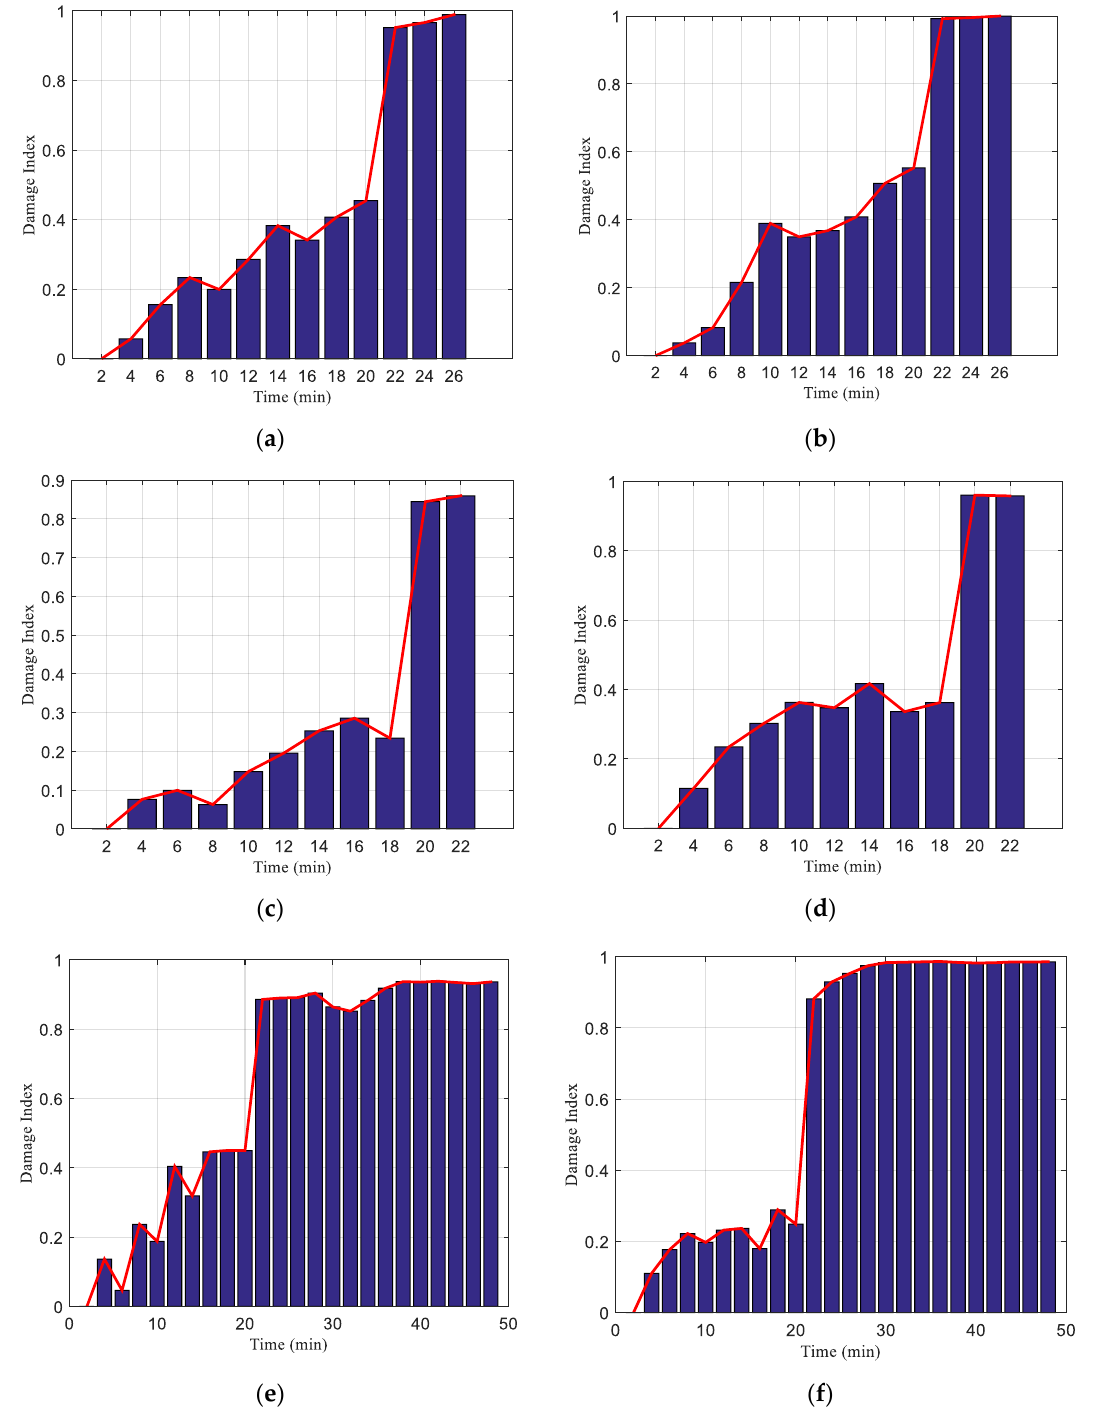
Figure 19. Shear failure damage index of Composite specimen monitored by SAs: ( a ) SA 3 in Composite specimen I; ( b ) SA 4 in Composite specimen I; ( c ) SA 3 in Composite specimen II; ( d ) SA 4 in Composite specimen II; ( e ) SA 3 in Composite specimen III; ( f ) SA 4 in Composite specimen III.